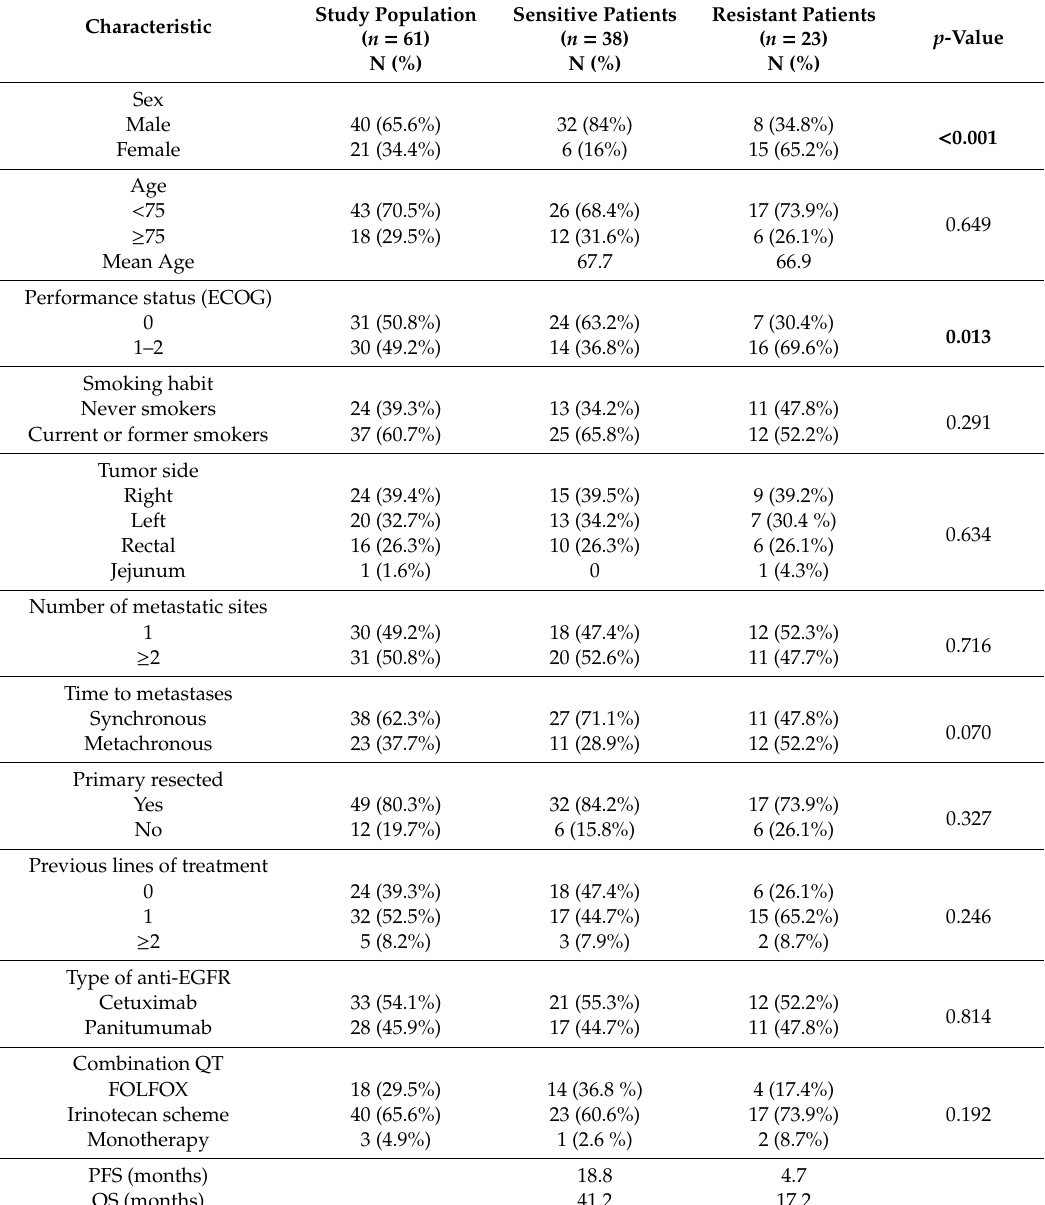
Table 2. Baseline patient